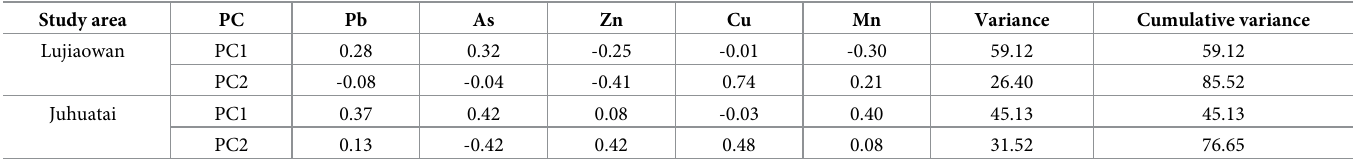
Table 8. The principal component analysis results of heavy